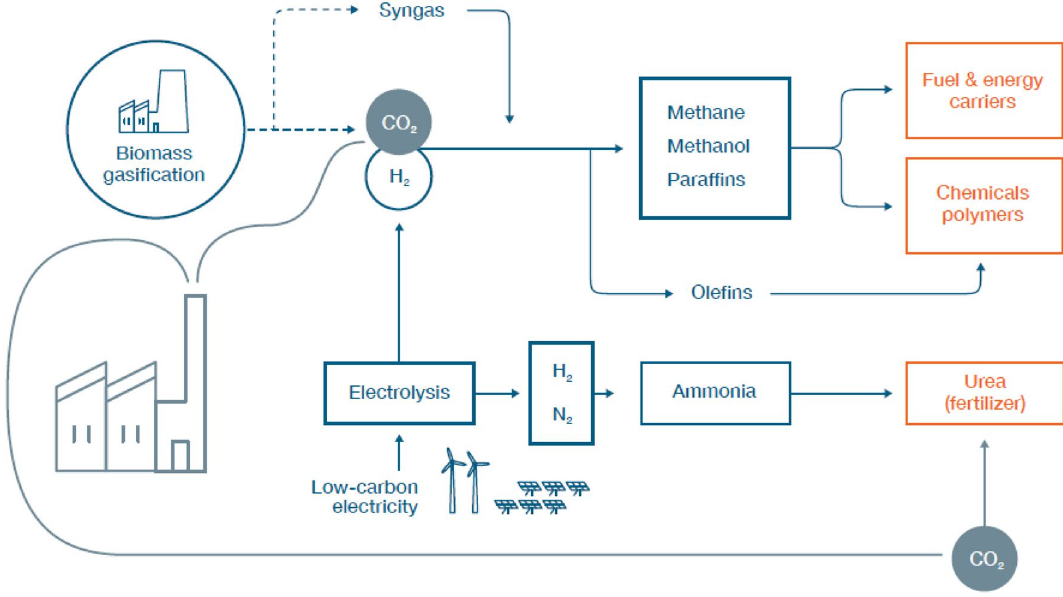
Fig. 5 P2X chemical paths to chemicals, and energy carriers including “blue” olefins. Scheme from ref